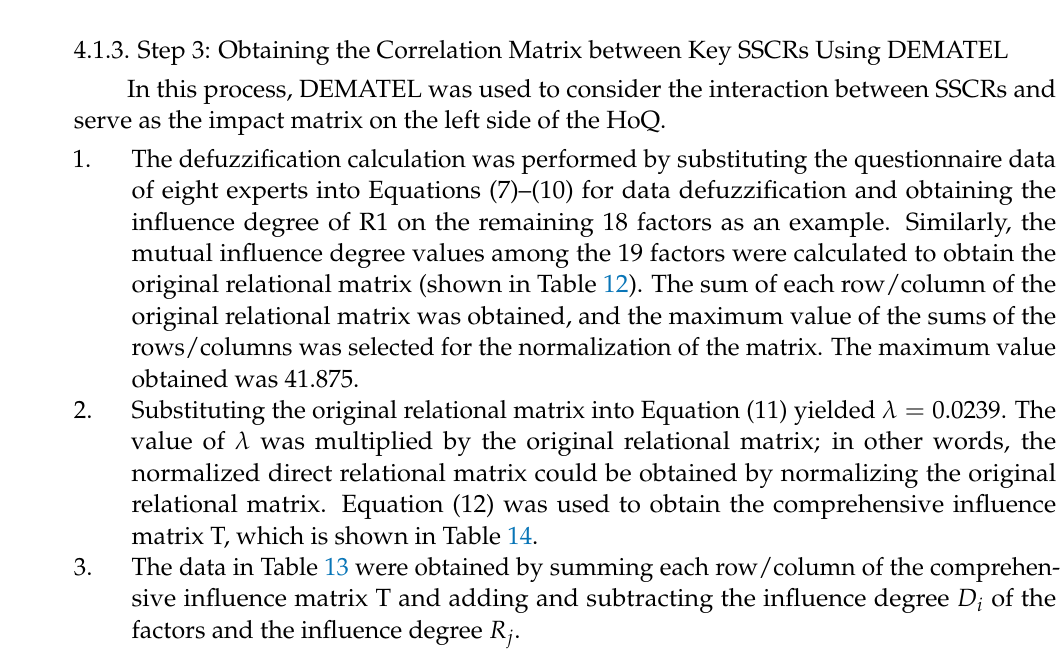
Table 12. Raw relational matrix of